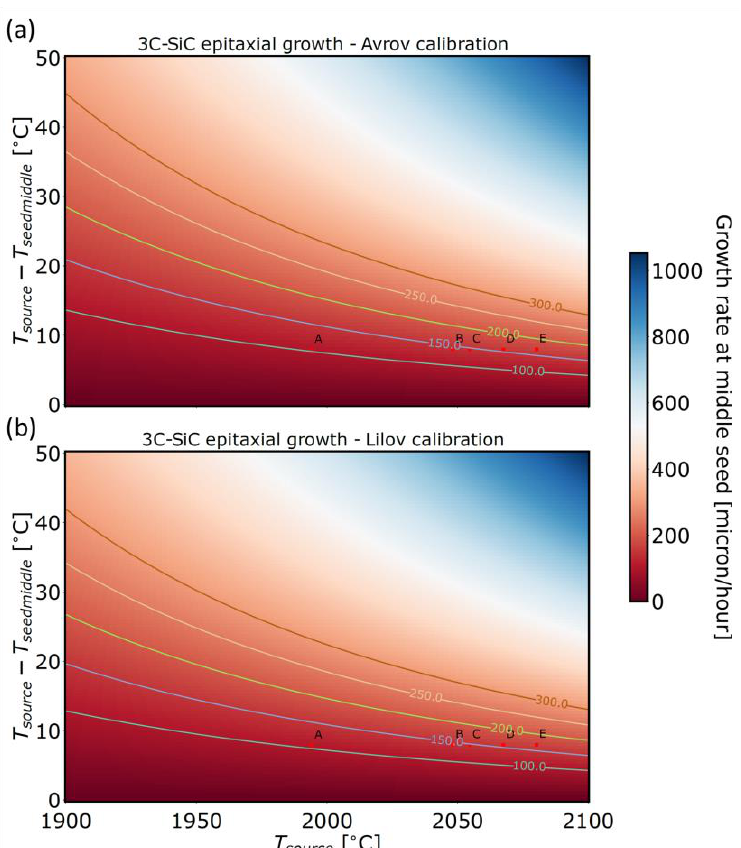
Figure 6. Two-dimensional map showing the growth rate variation (color scale) at the middle substrate position as a function of the source temperature (x-axes) and the temperature difference between the source and the seed at the middle-seed position (y-axes). Left ( a ) (Avrov [34]) and right ( b ) (Lilov [48]) panels refer to two different calibrations for the vapor gas pressures in the proximity of a cubic SiC substrate. The letters A,B,C,D,E indicate the growth conditions considered in this work for experiments and simulations (see Table 1). Isolines are also drawn to guide the eye.